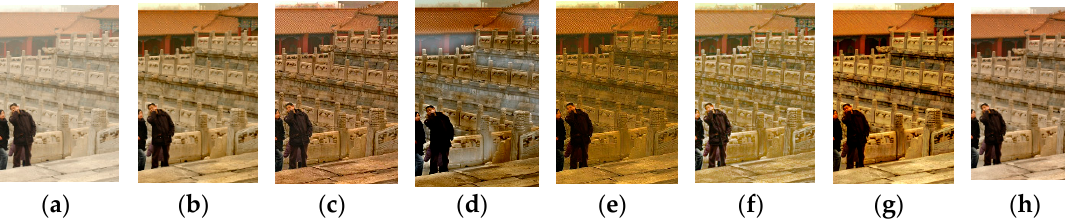
Figure 17. Qualitative comparison on hazy image with large white/gray regions. ( a ) Hazy image with large white/gray regions. ( b ) He et al.’s result. ( c ) Meng et al.’s result. ( d ) Ancuti et al.’s result. ( e ) Yu et al.’s result. ( f ) Tarel et al.’s result. ( g ) Choi et al.’s result. ( h ) Our result.